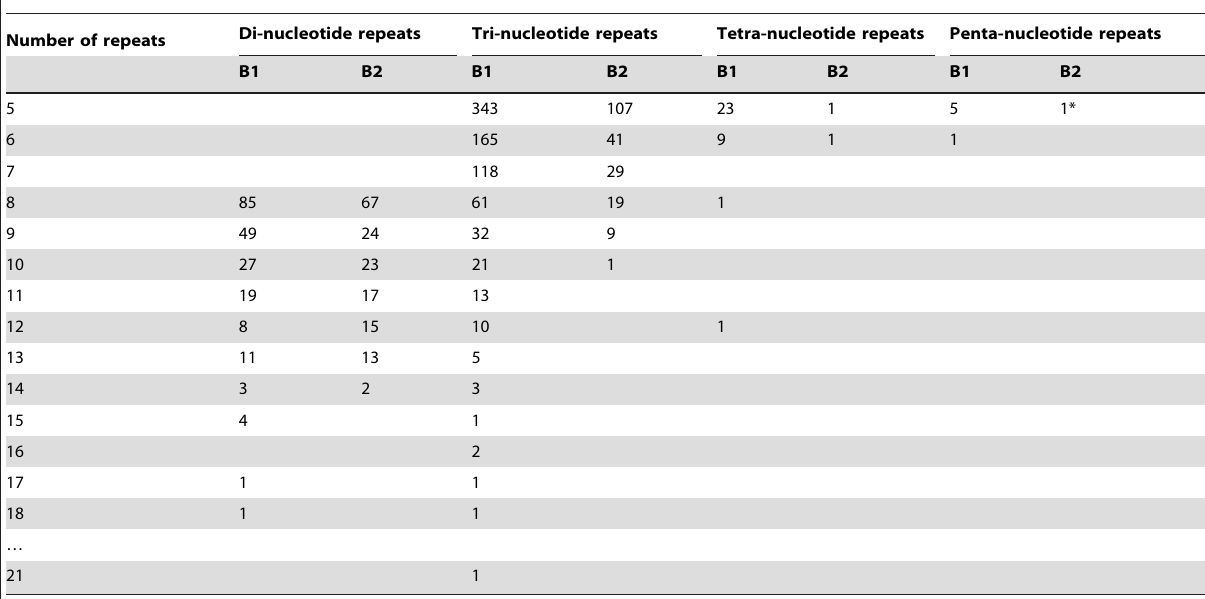
Table 3. Summary of microsatellite loci predicted in A. glycines sequences.